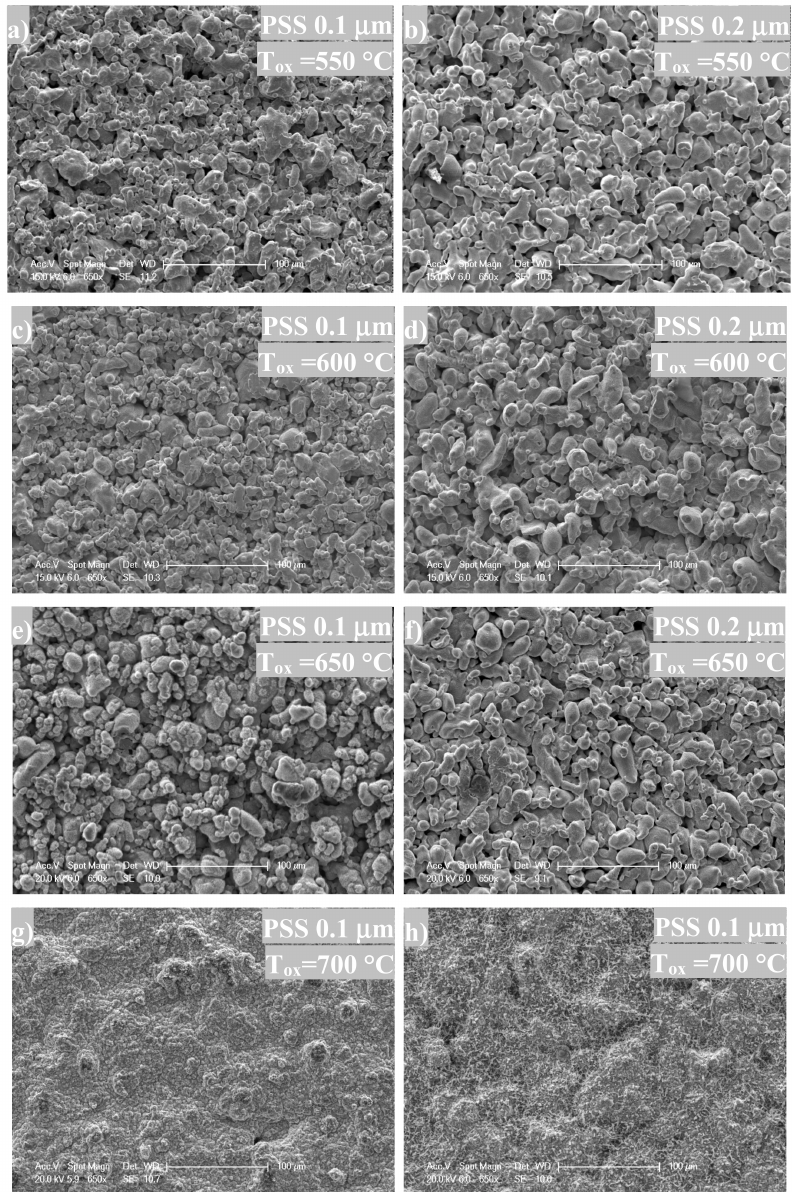
Figure 4. SEM images of PSS supports after 12 h in-situ oxidation: ( a ) media grade 0.1 µ m, T ox = 550 ◦ C; ( b ) media grade 0.2 µ m, T ox = 550 ◦ C; ( c ) media grade 0.1 µ m, T ox = 600 ◦ C; ( d ) media grade 0.2 µ m, T ox = 600 ◦ C; ( e ) media grade 0.1 µ m, T ox = 650 ◦ C; ( f ) media grade 0.2 µ m, T ox = 650 ◦ C; ( g ) media grade 0.1 µ m, T ox = 700 ◦ C; and ( h ) grade 0.2 µ m, T ox = 700 ◦